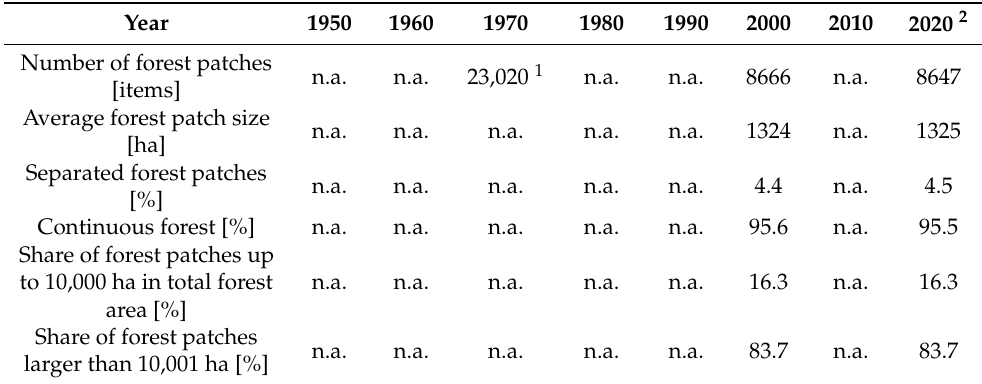
Table 2. Fragmentation of Polish forests